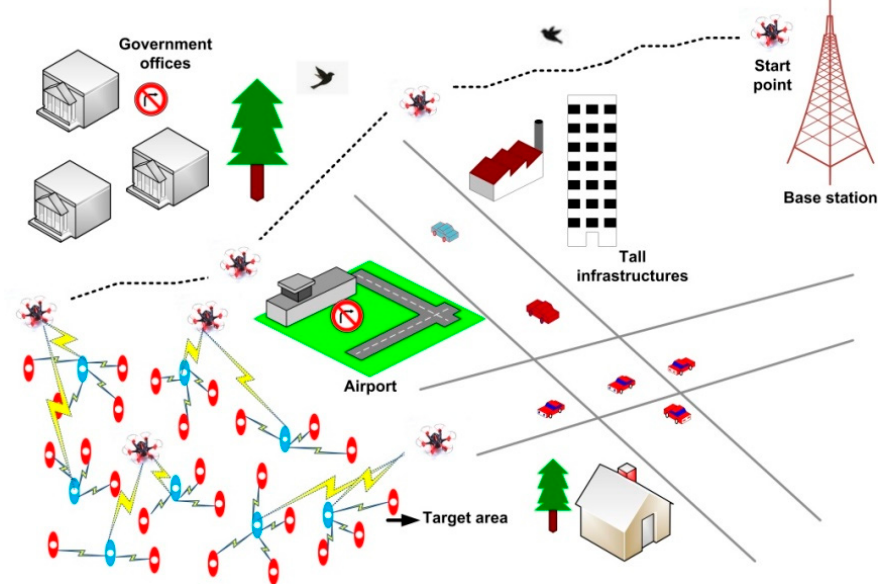
Figure 1. Example of UAV path planning in a UWSN.